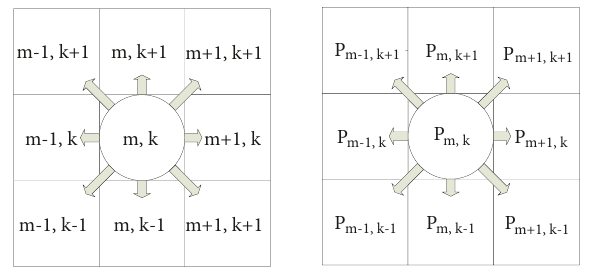
Figure 2: The scheme of Moore